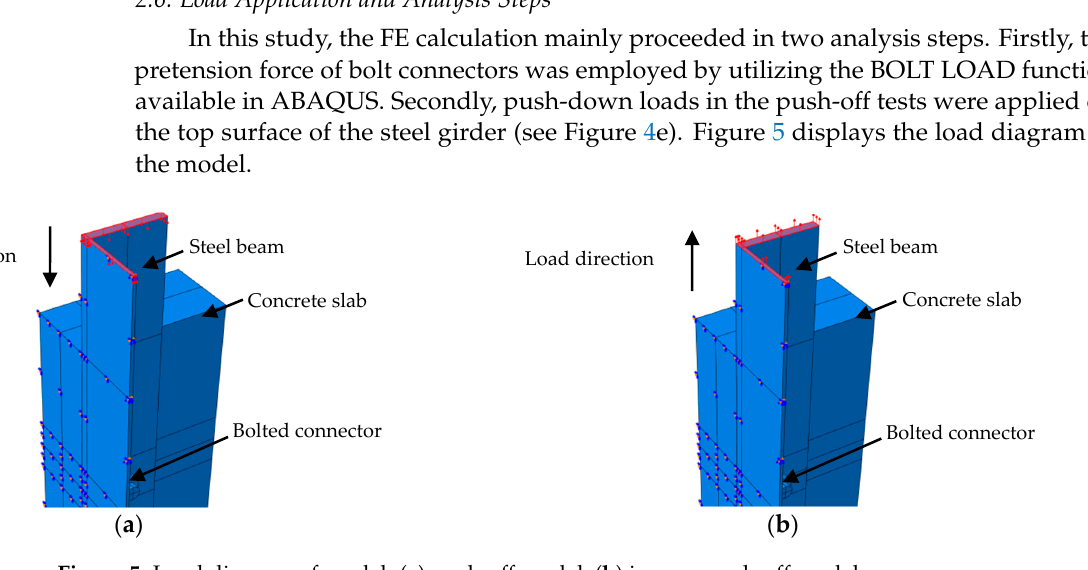
Figure 5. Load diagram of model: ( a ) push-off model; ( b ) inverse push-off model.